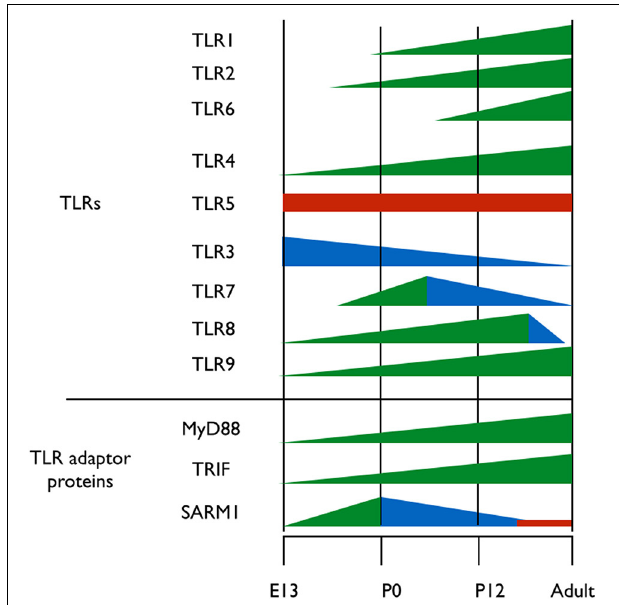
FIGURE 2 | Expression pattern of TLRs and their adaptor proteins throughout brain development. TLRs 1-9 and the TIR adaptor proteins MyD88, TRIF, and SARM1 were thus far analyzed for their protein expression levels during brain development. Different colors represent changes in proteins expression levels; green represents increased expression, blue represents decreased expression and red represents stable